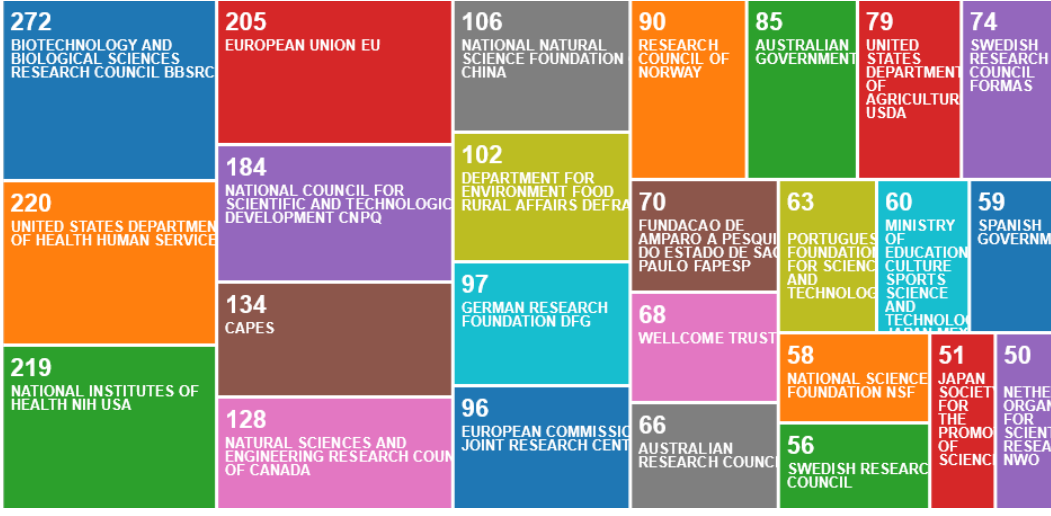
Figure 8. Number of publications per funding agency, according to an online survey of animal welfare